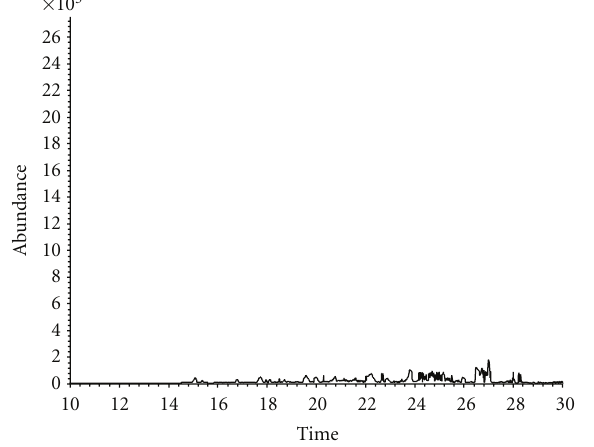
Figure 5: Chromatogram of refinery wastewater after treatment under optimum conditions after 120